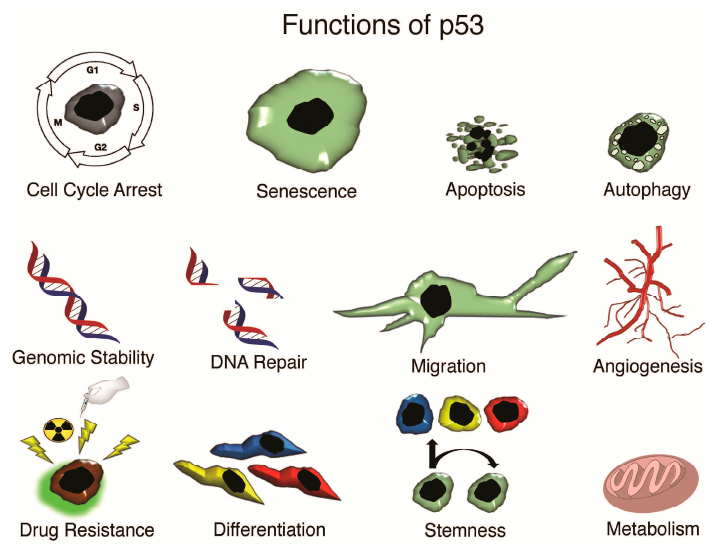
Figure 1. Functions of p53.